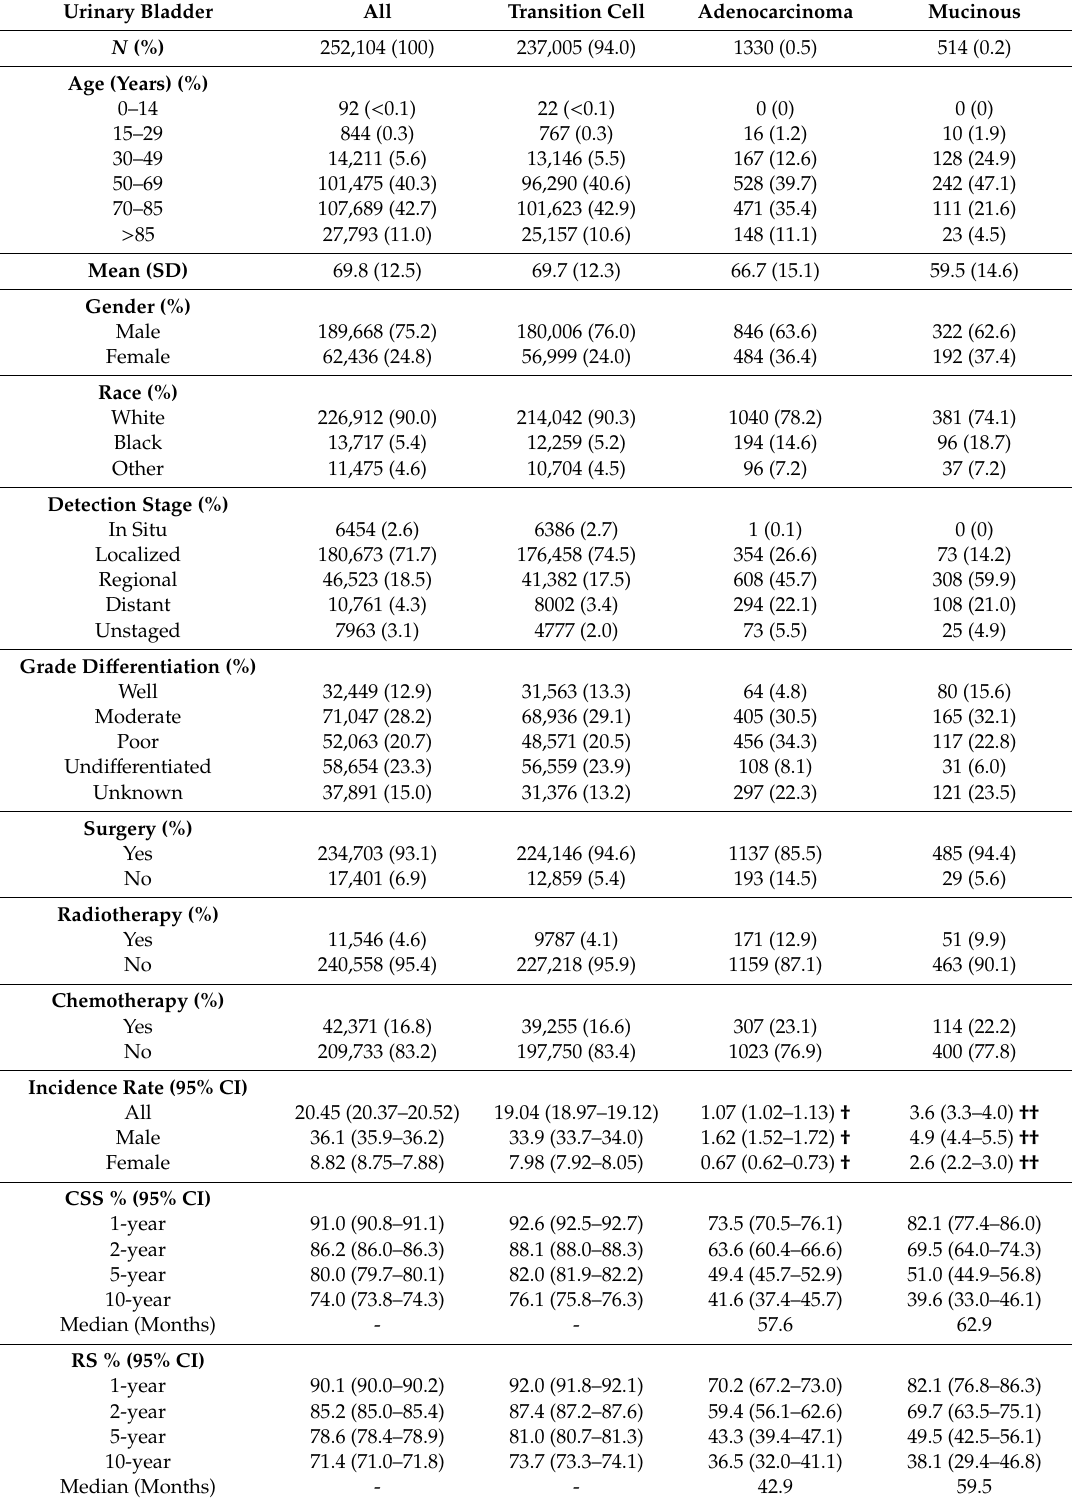
Table 23. Baseline demographics and clinical characteristics by histology for urinary bladder